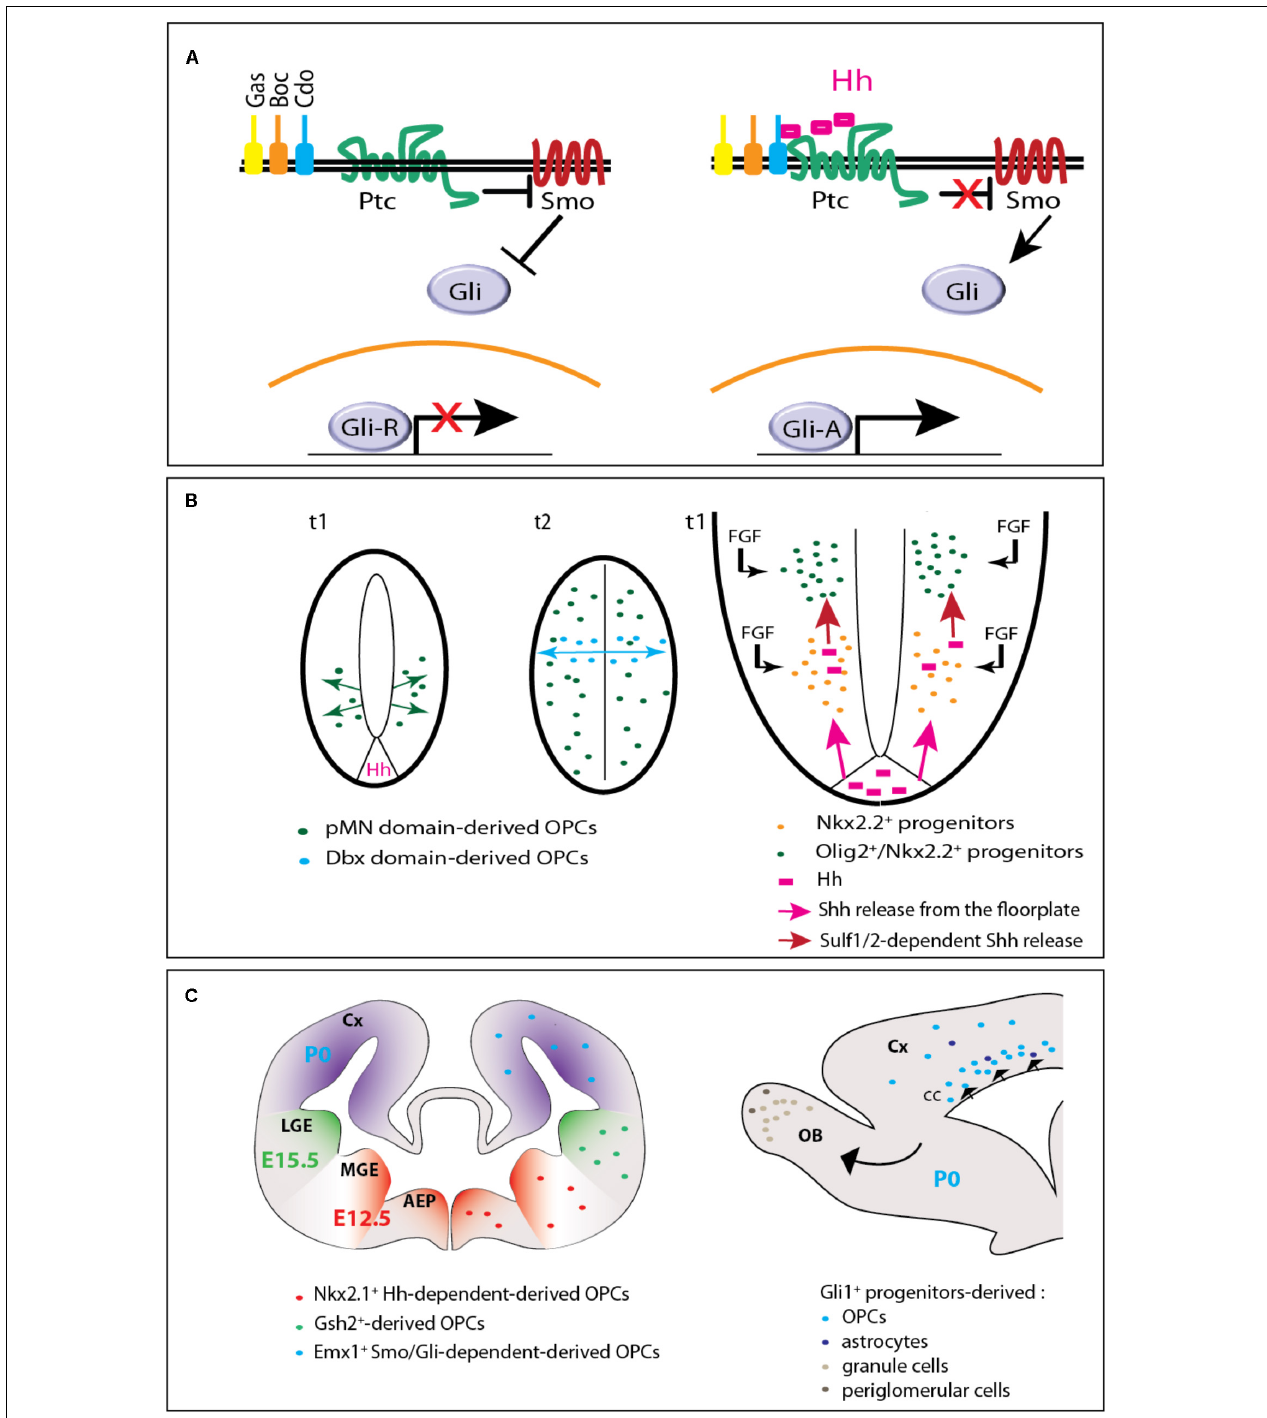
FIGURE 1 | Hedgehog signaling in embryonic and postnatal oligodendrogenesis. (A) The Hedgehog signaling pathway. In the absence of Hedgehog (left), the receptor Patched (Ptc) exerts a repressive activity on Smoothened (Smo). When Hedgehog (Hh) binds Ptc and one of its co-receptors (Gas, Boc, or Cdo), Smo repression is relieved triggering an intracellular signaling cascade that involves the transcription factors of the Gli family. The Gli activator (GliA) instead of the Gli repressor (GliR) form is then transported toward the nucleus and subsequently leads to the transcription of target genes. (B) Hedgehog-dependent OPC production in the embryonic spinal cord. On the left (adapted from Fogarty et al., 2005), two cross-sectional views of the neural tube are shown. t1 and t2 indicate the embryonic days when ventral and dorsal OPCs are produced, respectively. At t1, OPCs arise from the pMN domain in a Hedgehog (Hh)-dependent manner. At t2,